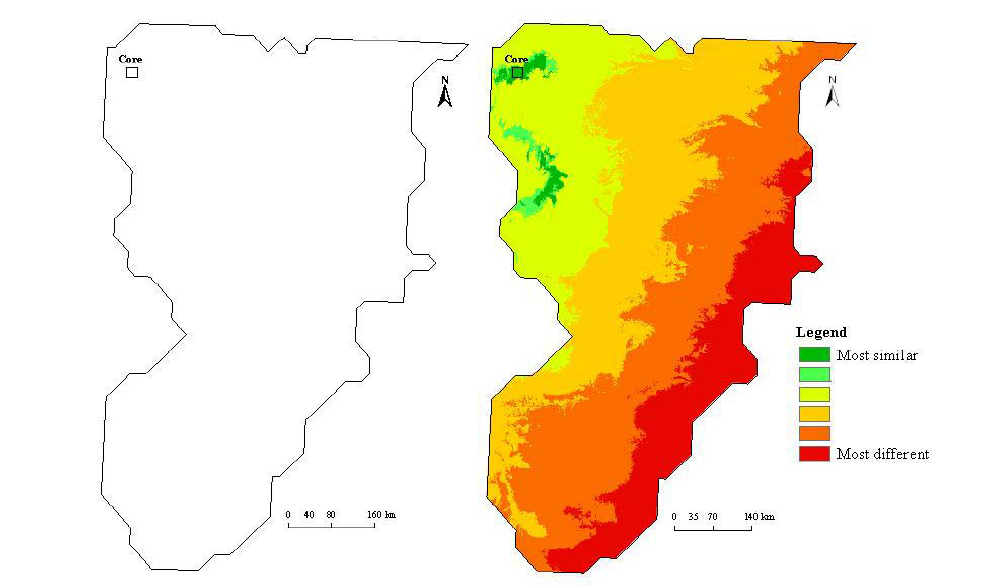
Figure 2. Core site model results with zones of similarity and differences.